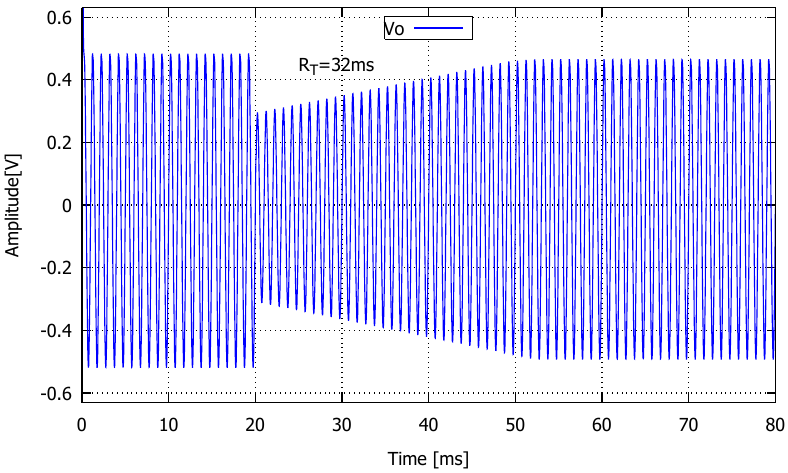
Figure 12. Analog AGC transient response for V REF = 500 mV, with R T = 32